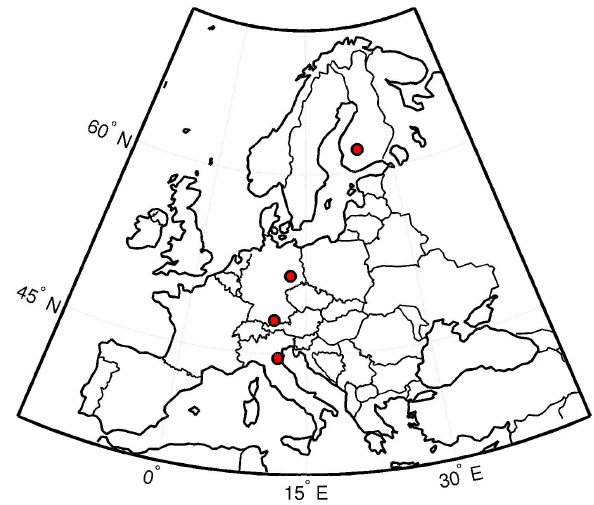
Fig. 1. Map of the measurement sites. Sites from north to south: Hyyti¨al¨a (Finland), Melpitz (Germany), Hohenpeissenberg (Ger- many) and San Pietro Capofiume